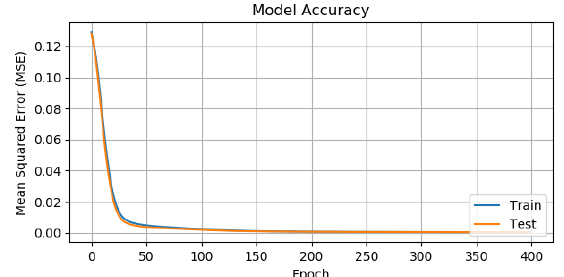
Figure 7. Autoencoder precision model